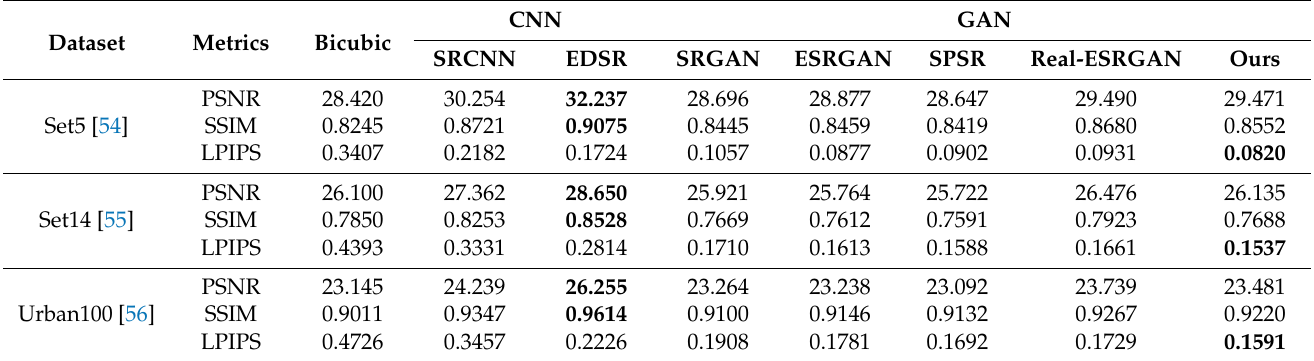
Table 4. Mean values of PSNR, SSIM and LPIPS for different methods in Set5, Set14 and Urban100. The best performance in